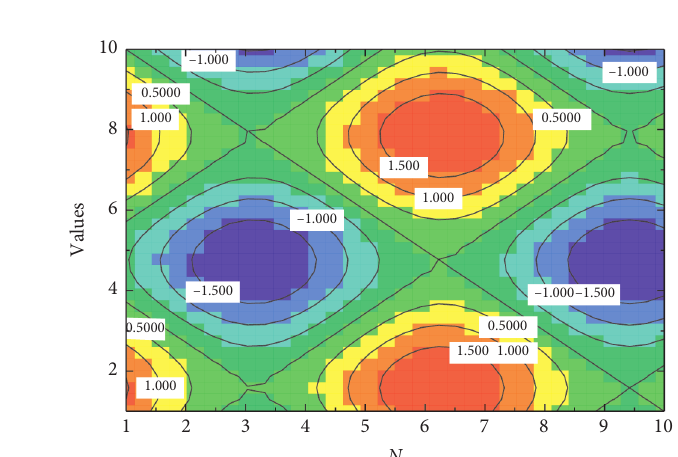
Figure 9: Performance